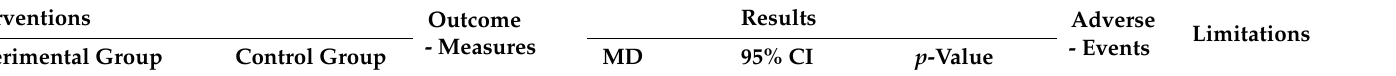
Table 1. Characteristics of the included randomized controlled